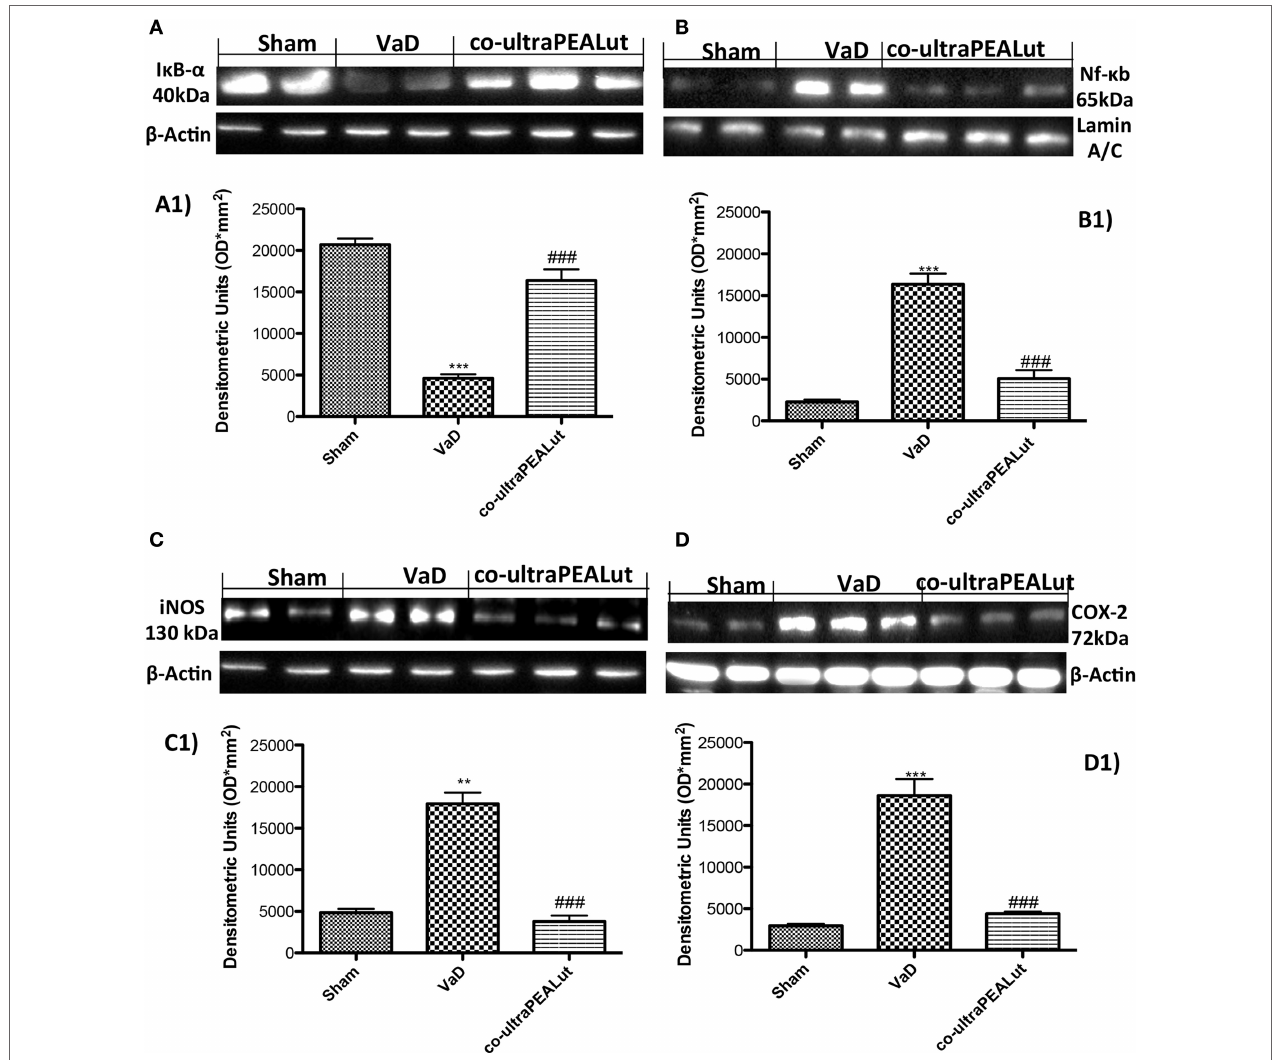
FigUre 4 | effects of co-ultraPealut treatment on nF- κ B pathways, inducible nitric oxide synthase (inOs) and cyclooxygenase - 2 (cOX-2) expression . Western blot analysis for I κ B- α and NF- κ B proteins in the brain were detected at 15 days after carotid arteries occlusion. I κ B- α levels were